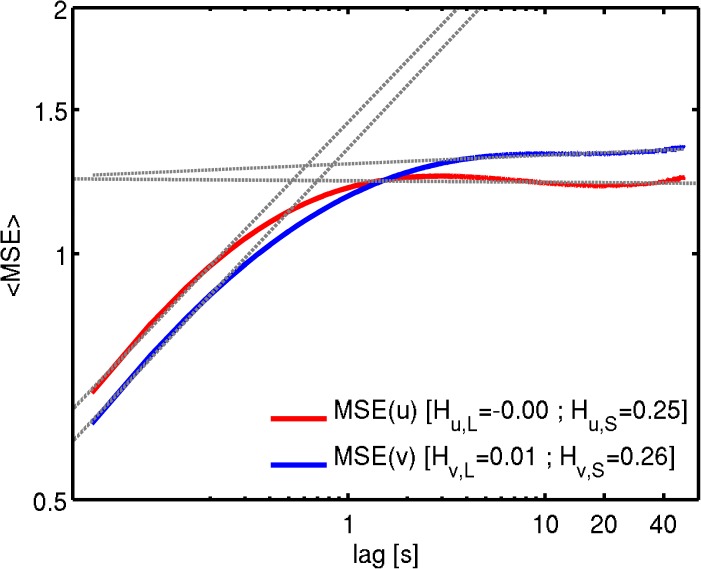
Log-log plots of ensemble averaged MSE computed from all the valid CASE-99 time-series for zonal wind (red) and meridional wind (blue).The dashed grey lines are the linear regression fits, with the corresponding slopes identified in the legend.